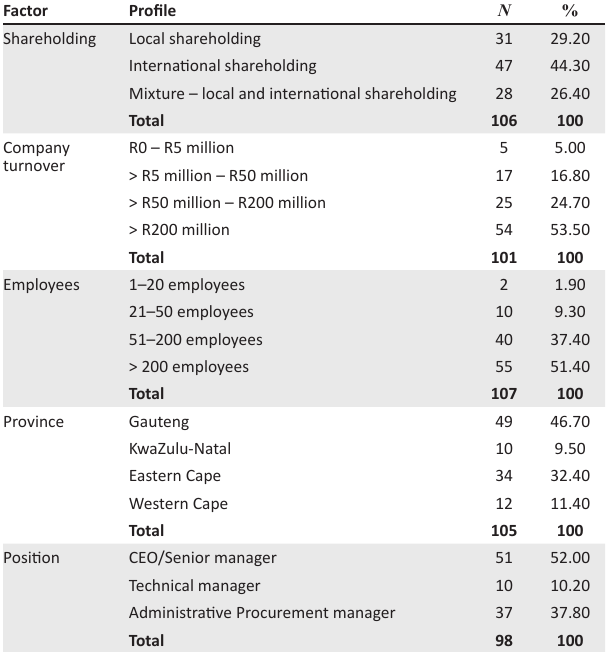
TABLE 4: Profile of respondents. TABLE 5: Descriptive statistics: Trust and relationship value.